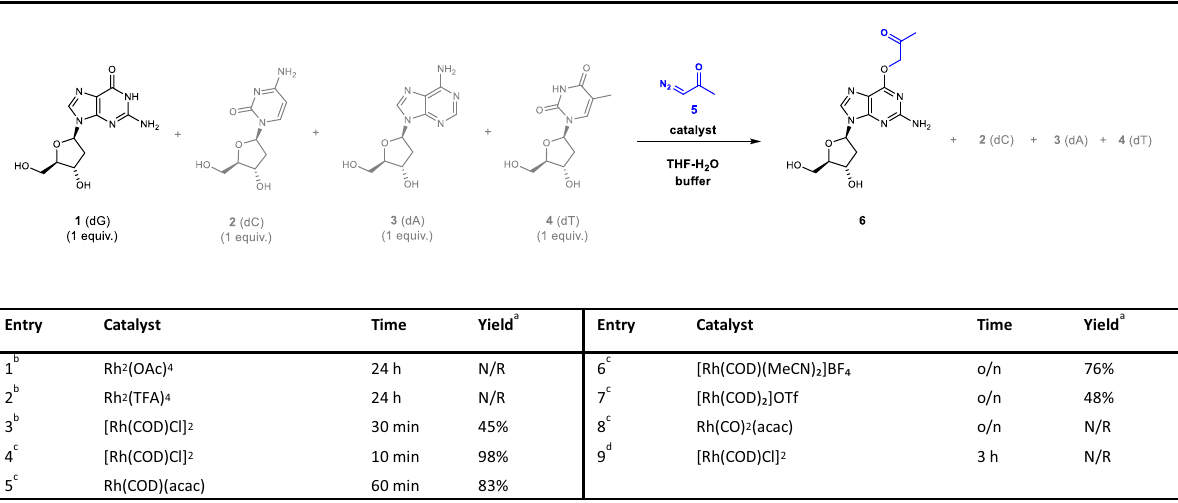
Fig. 2 Optimization of Rh(I)-catalyzed O 6 -G labeling. a Based on HPLC analysis. b Conditions a: each nucleoside (5 mM), catalyst (5 mol%), diazoacetone (1.2 equiv.), 50% THF-H 2 O, r.t. c Conditions b: each nucleoside (5 mM), catalyst (10 mol%), diazoacetone (8 equiv.), 10% THF-H 2 O, MES (20 mM),